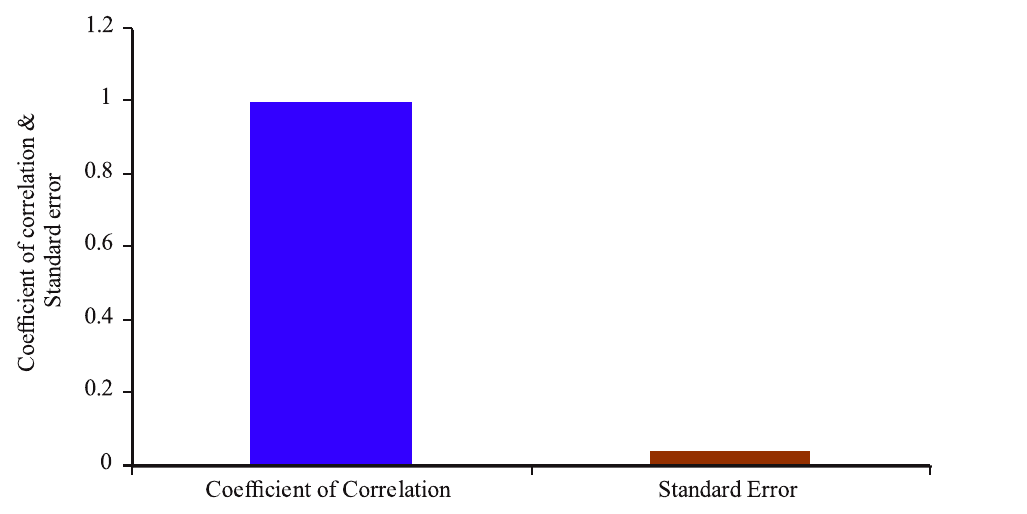
FIG. 8. BAR CHART OF COEFFICIENT OF CORRELATION AND STANDARD ERROR FOR OBJECTS